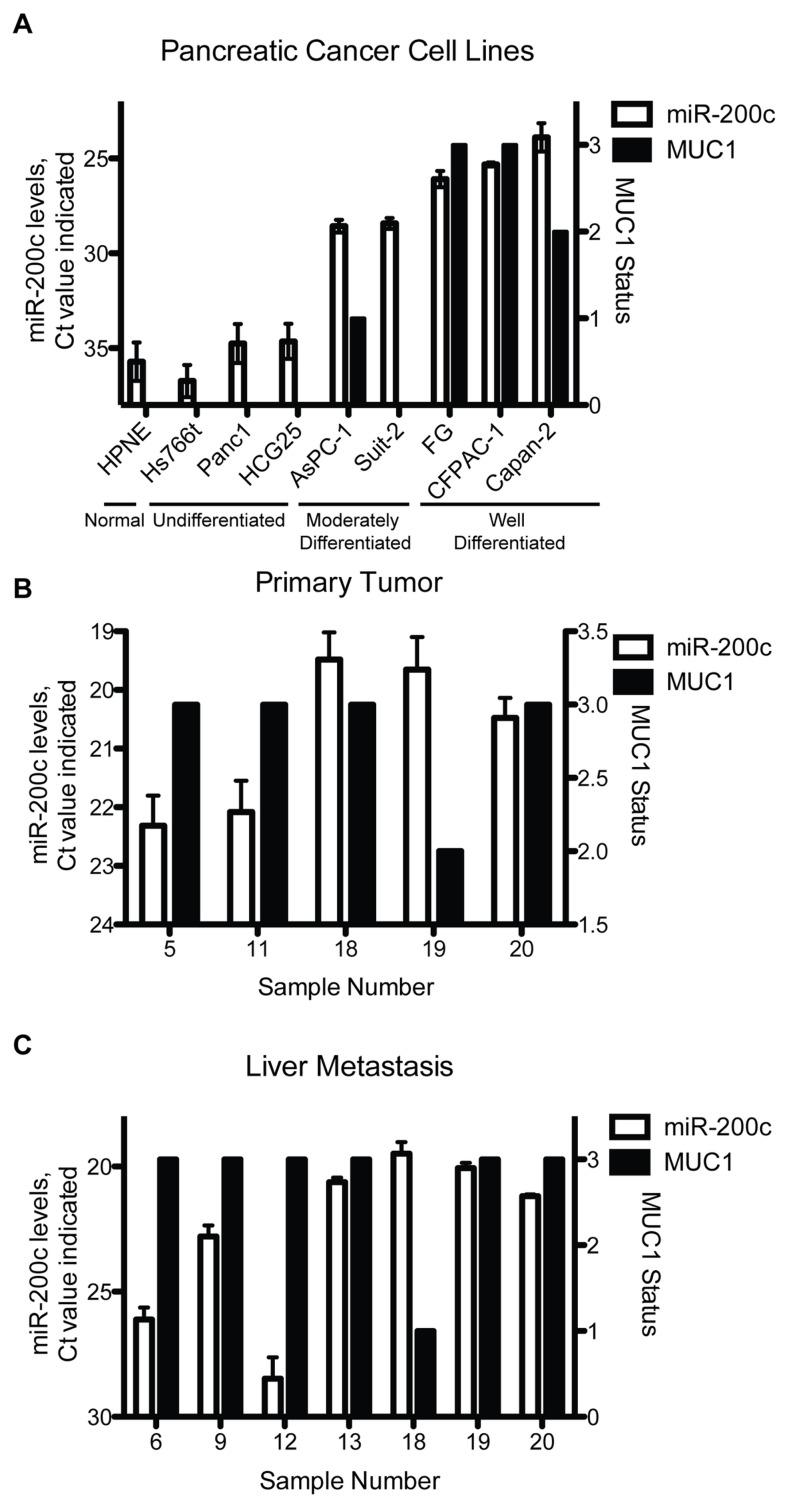
MiR-200c and MUC1 levels in a panel of pancreatic cancer cell lines and tumor samples.Correlation between levels of MUC1 and miR-200c in a panel of pancreatic cancer cell lines and a panel of primary tumor sections and liver metastases. A) MiR-200c levels, indicated by Ct value, are the white bars and correspond to the left y-axis. MUC1 statuses of these cell lines, determined by western blot, are represented in the black bars and right y-axis. Levels of miR-200c and their corresponding MUC1 levels [20], on the left and right y-axis respectively were evaluated in primary pancreatic tissue (B) and liver metastases (C). MUC1 status was determined based on IHC staining from one section per patient; therefore standard deviation was not determined.